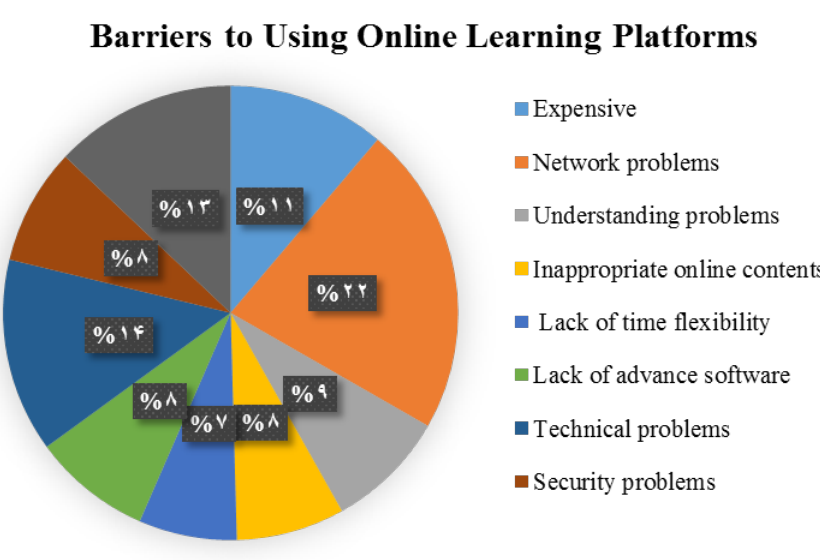
Figure - 7: Showing the barriers to using online learning platforms.